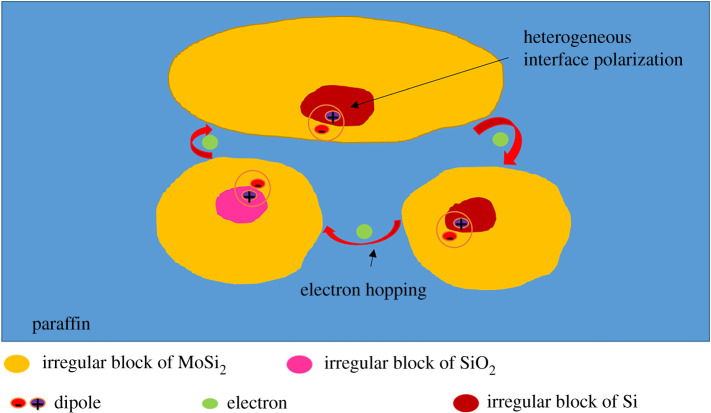
Interface effect and conductive network between SiO2, Si and MoSi2.